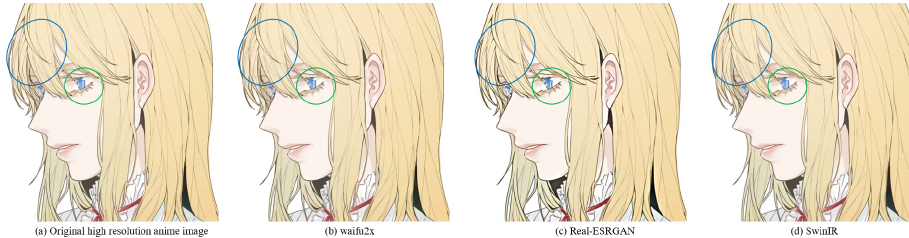
Figure 4. The results of super-resolution methods. ( a ) Original high-resolution anime image. ( b ) SR anime image generated by Waifu2x. ( c ) SR anime image generated by Real-ESRGAN. ( d ) SR anime image generated by SwinIR (image restoration using Swin Transformer). For Waifu2x, the blur and checkerboard artifacts problems are in the green and blue circles. For Real-ESRGAN, the circled area shows the hallucinations problem. For SwinIR, the circled area shows the lack of detail, such as line misjudgments. The image is adopted from